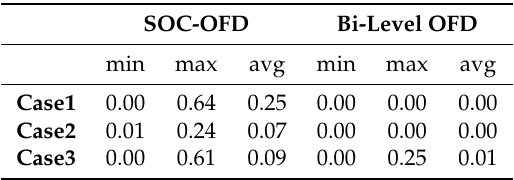
Table 3. The maximum, minimum, and average SOC-relaxation error (cid:101) SOC of all line flows, determined by SOC-OFD and bi-level-OFD models for the three